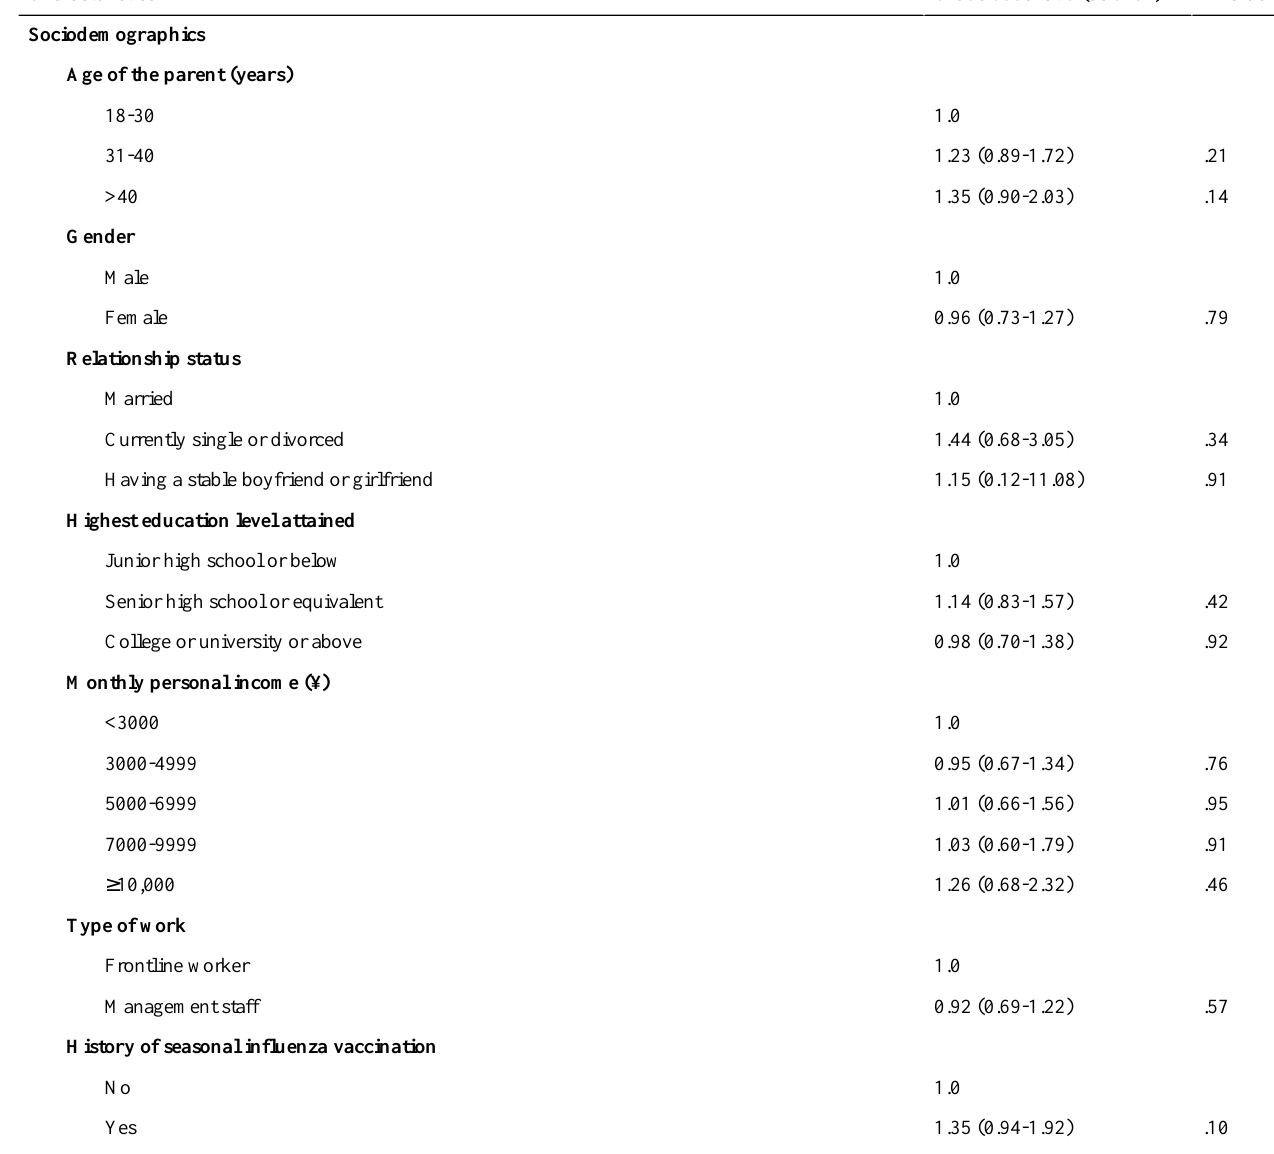
Table 3. Associations between background characteristics and parental acceptability of free COVID-19 vaccination